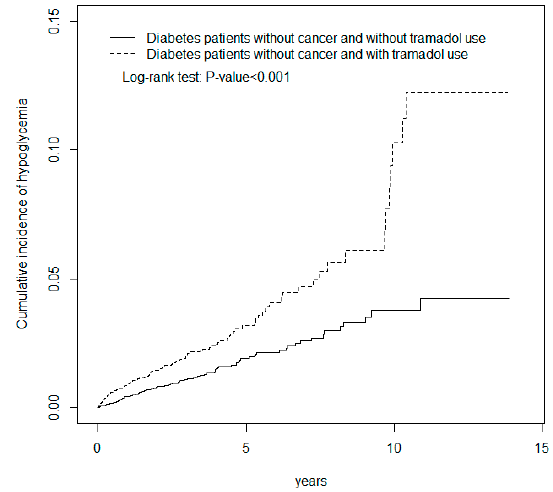
Figure 1. Cumulative incidence of hypoglycemia for patients with (dashed line) or without (solid line) tramadol use among diabetes patients without cancer.